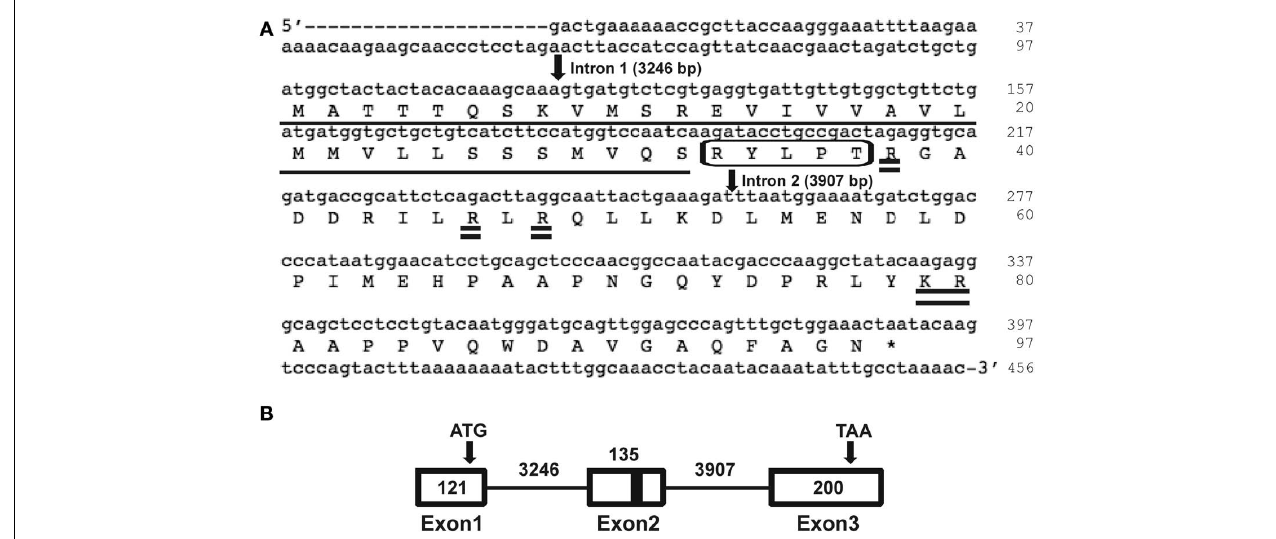
underlined with the predicted cleavage occurring between the amino acids S (32) and R (33).The position and the length of the two introns are indicated by arrows. (B) Schematic diagram representing the genomic organization of the proctolin gene in R . prolixus . Boxes represent exons and solid lines represent introns. Arrows represent the start codon (ATG) and the stop codon (TAA). Black bar represents region encoding proctolin. Numbers indicate the nucleotide length for the corresponding exons and